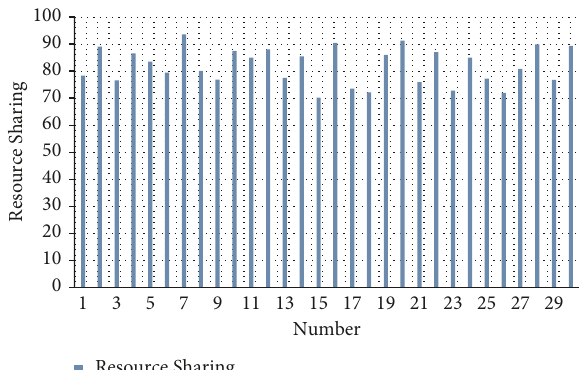
Figure 10: Statistical diagram of the evaluation of the online teaching resource sharing system of spoken